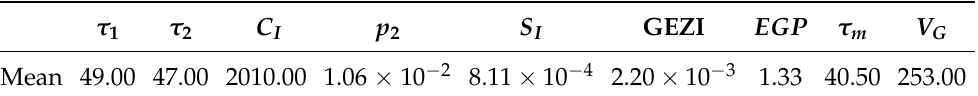
Table 1. Mean values adopted to generate the parameters for virtual patients with the IVP model. τ 1 τ 2